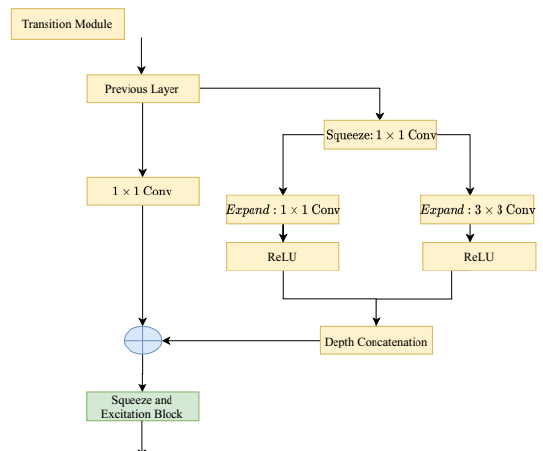
denotes element- wise addition . ⊕